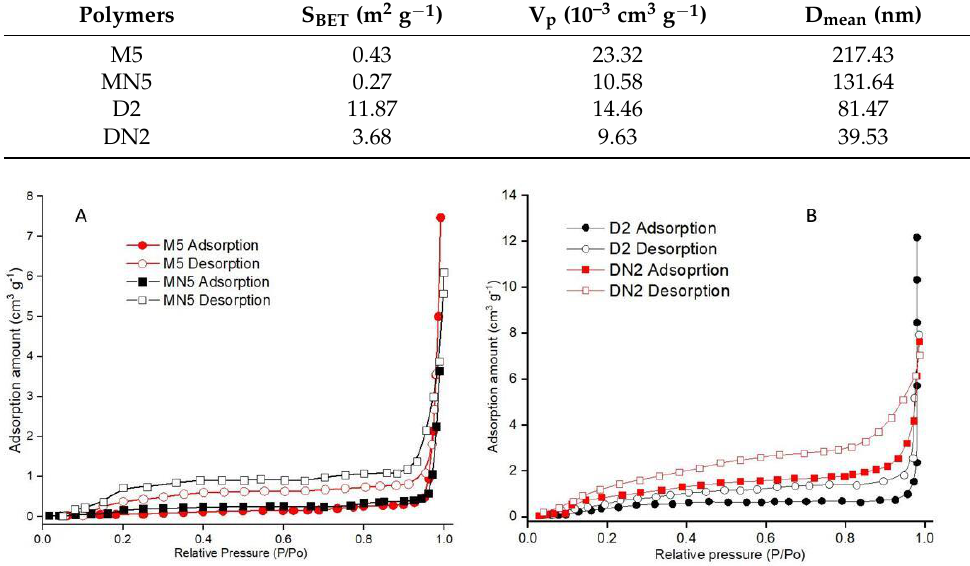
Figure 5. Nitrogen adsorption isotherms of ( A ) M5 and MN5, and ( B ) D2 and DN2. Table 2. The surface area, pore volume, and pore size of the synthesized polymers.